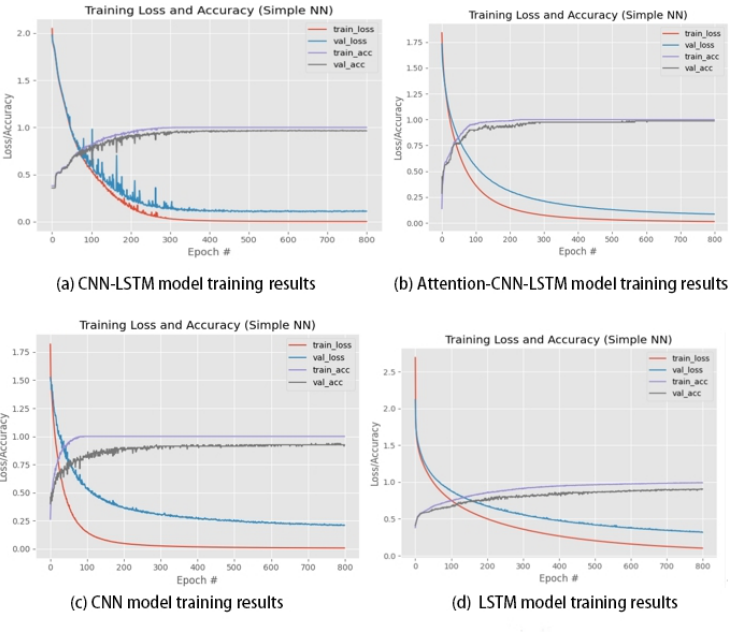
Figure 12. Four model training